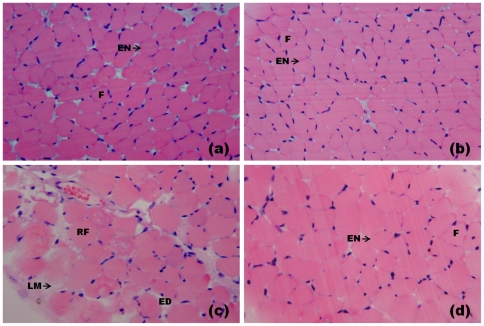
Light micrographs of mouse diaphragm muscles submitted to hematoxilin and eosin staining.Control muscle (a) and muscle exposed to RA (b) show fibers with normal appearance as evidenced by the polygonal aspect of fibers (F) and endomysium (EN). (c) Muscle exposed to PrTX-I: edema (ED), round fibers (RF) some of which present loss of myofibrils (LM). (d) Muscle exposed to PrTX-I pre-incubated with RA: most fibers present a normal appearance.